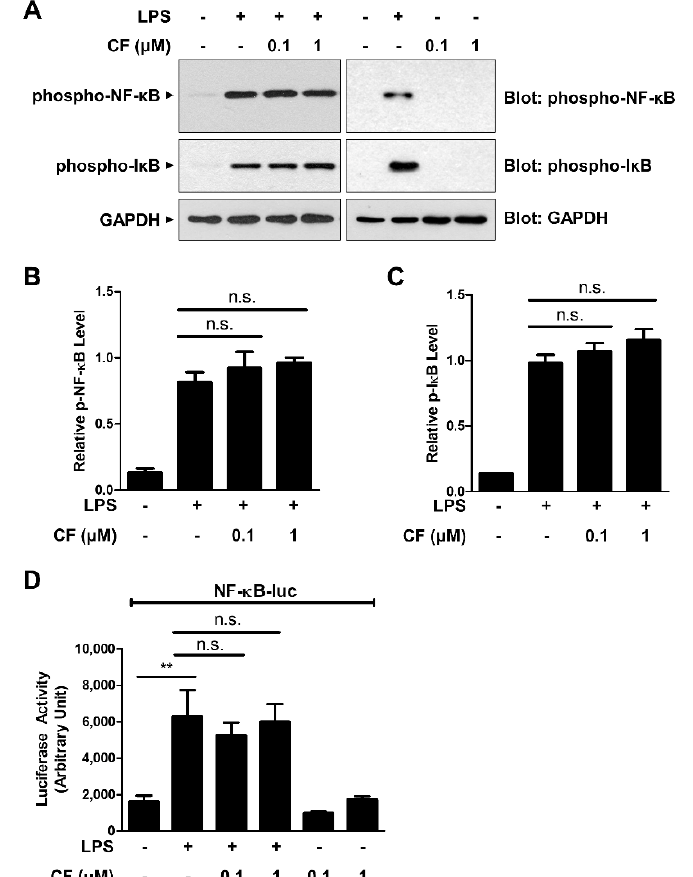
Figure 2. CF does not regulate the NF- κ B signaling pathway. ( A – C ) RAW264.7 macrophage cells were treated with CF (0.1 and 1 µ M) for 30 min before treatment with LPS (500 ng/mL) for 6 h. Western blot analysis was performed with anti-phospho-NF- κ B (p65) and anti-phospho-I κ B antibodies ( A ) and then quantified ( B , C ). ( D ) The NF- κ B-luciferase reporter vector was transfected into RAW264.7 cells. After 24 h, the cells were pretreated with CF for 30 min before LPS (500 ng/mL) treatment for 6 h, and luciferase activity was measured. The graphs are the mean ± SD of three separate experiments. ** p < 0.01; n.s., nonsignificant.